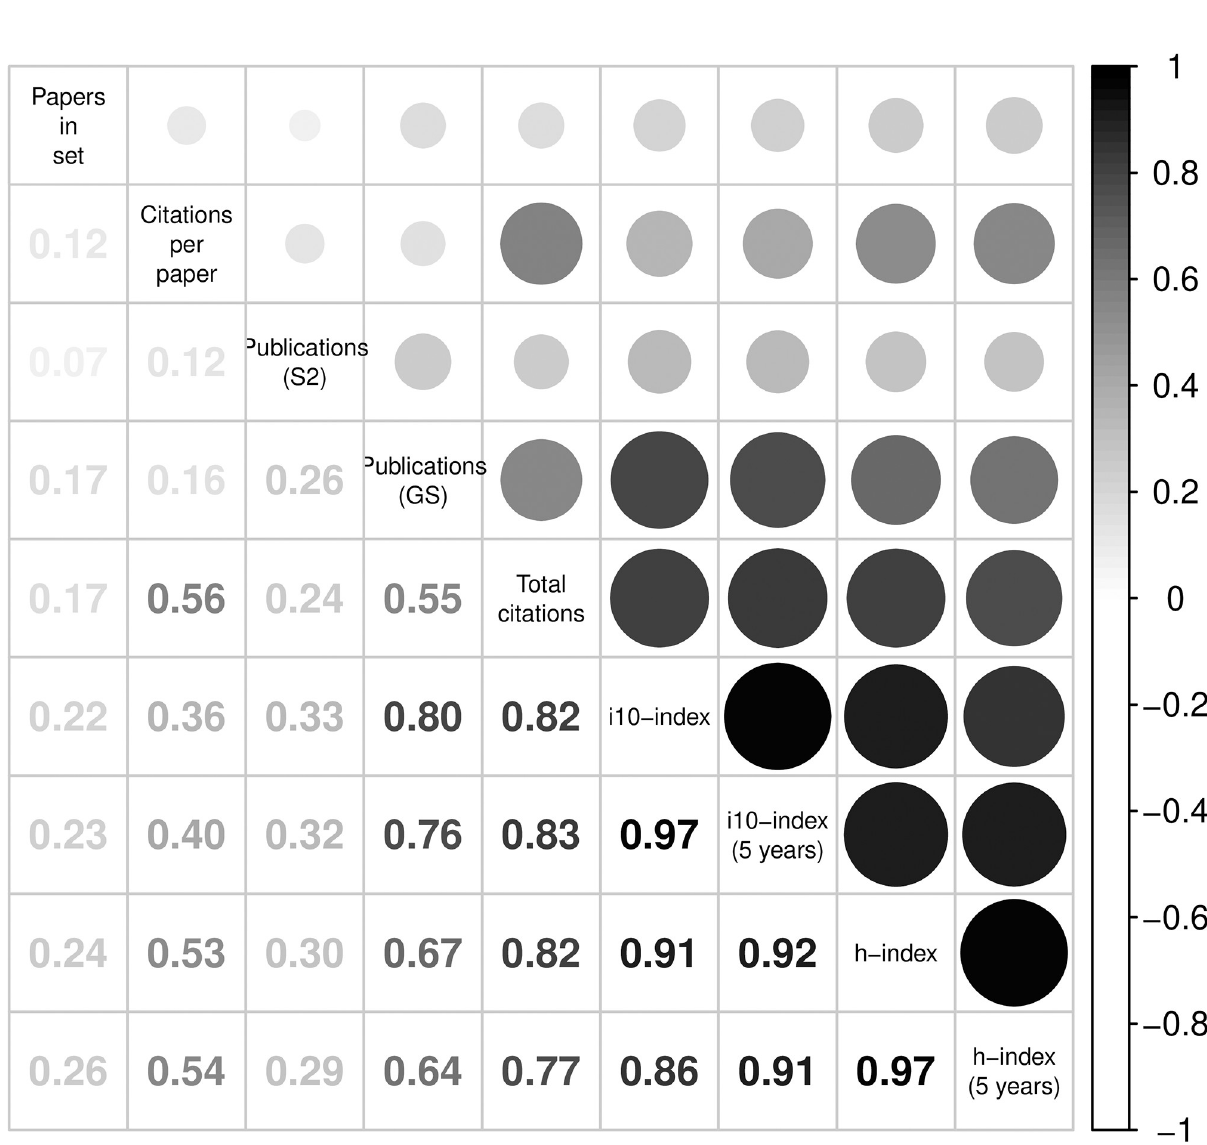
Fig 2. Correlation matrix for the author-level prestige